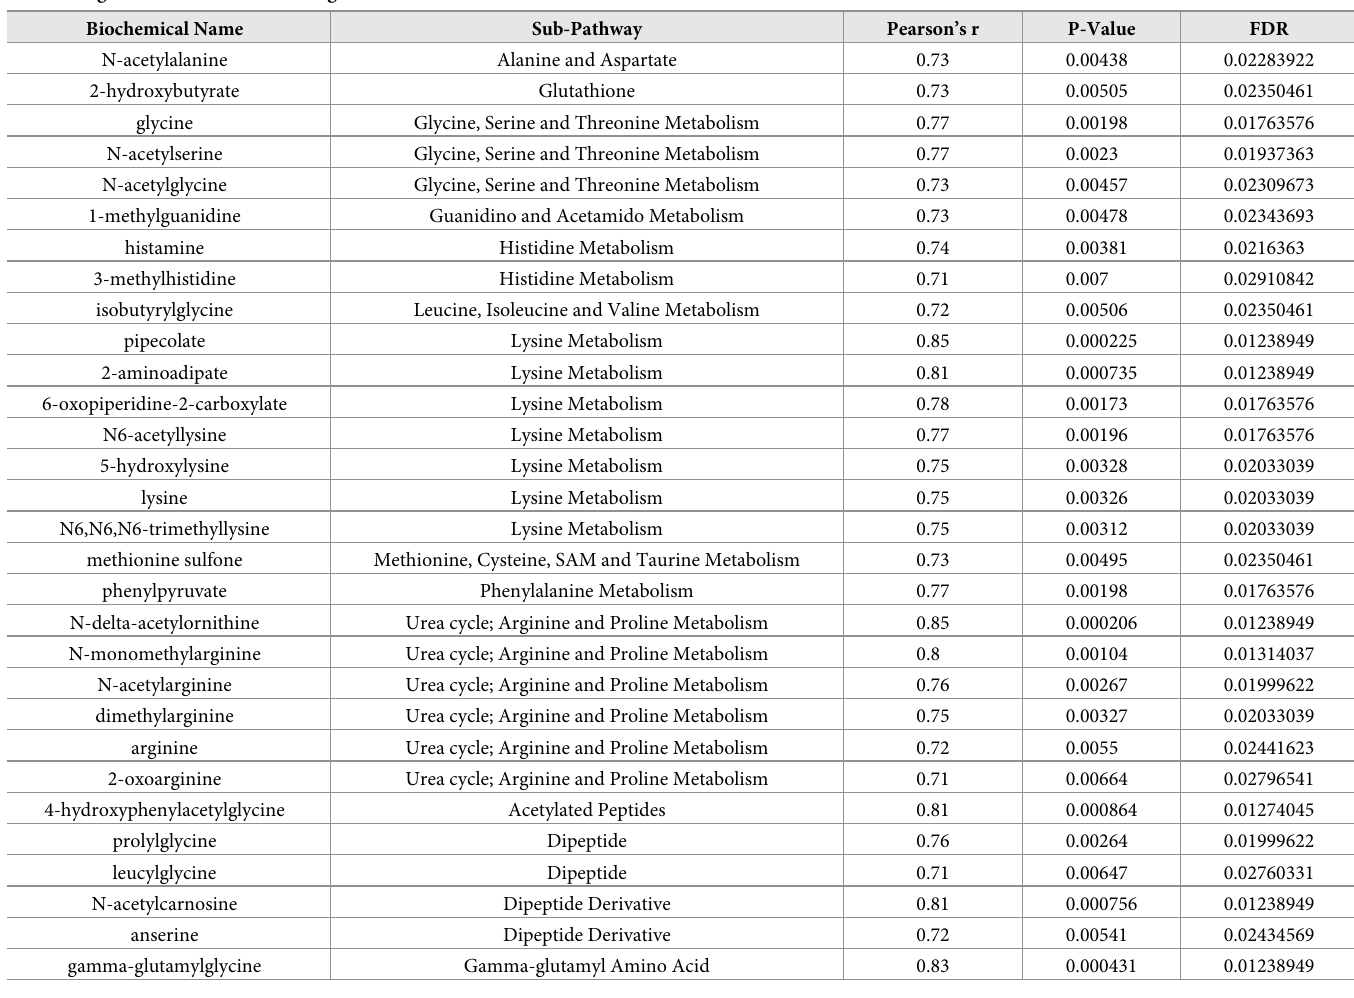
Table 3. Significant correlations among amino acid metabolites and fTLI in the serum. Biochemical